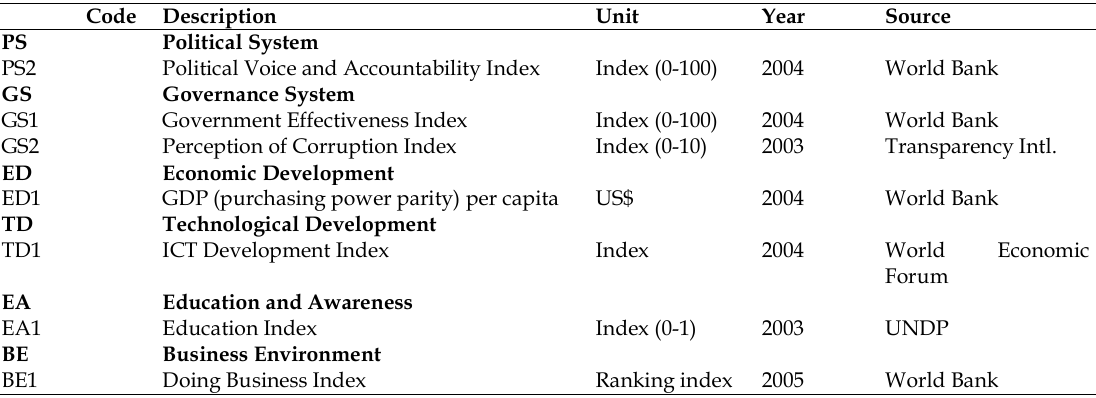
Table 4. Overview of country macro